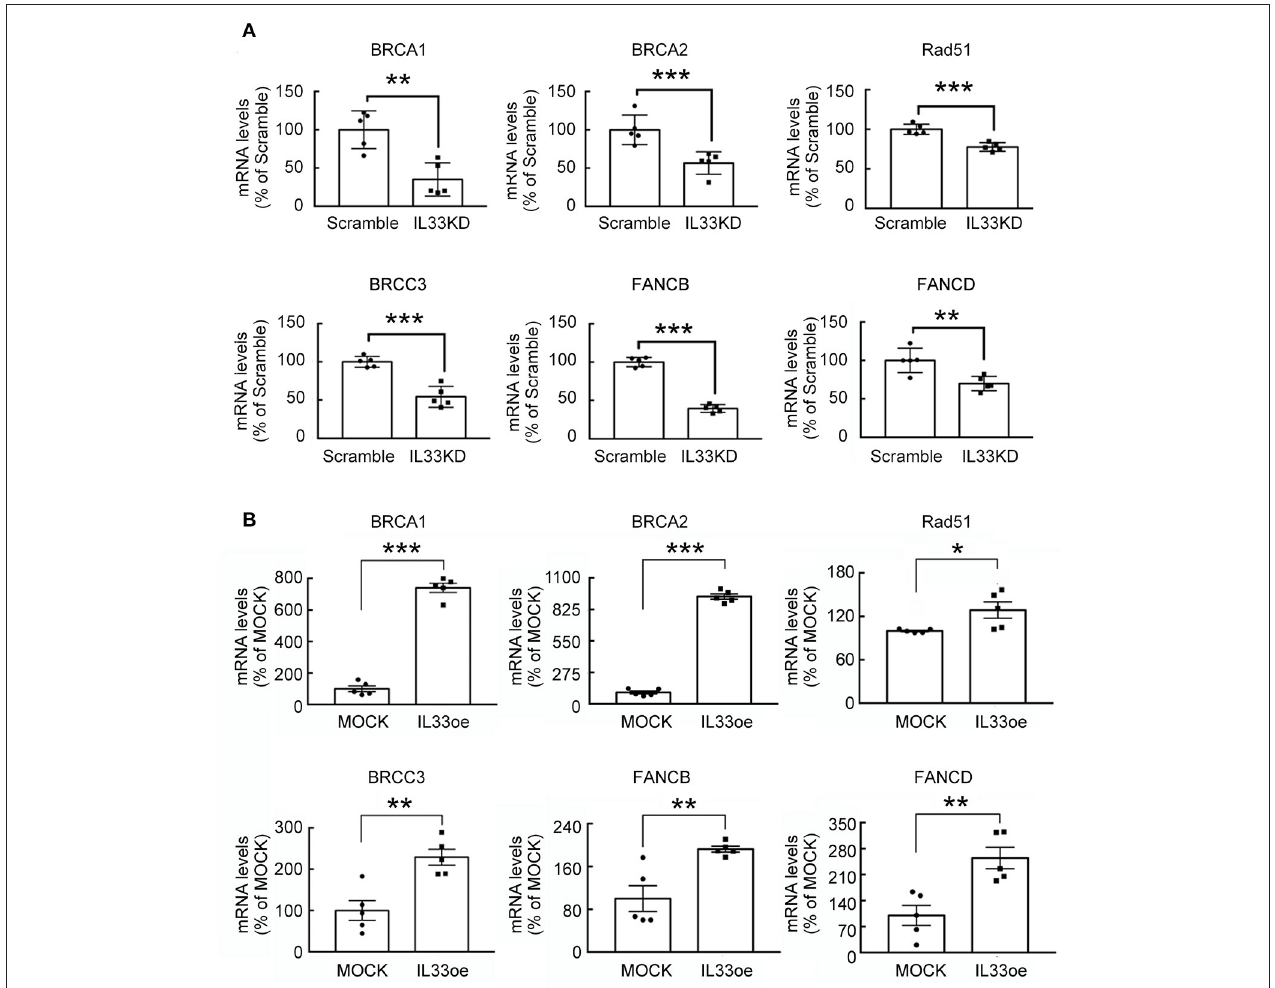
FIGURE 5 | DNA repair gene expression is mediated by IL-33 in U87MG cells. RNA samples were prepared from Scramble and IL33KD-U87MG cells (A) , as well as MOCK- and IL33oe-U87MG cells (B) . The expression of DNA repair genes (BRCA1, BRCA2, Rad51, BRCC3, FANCB, and FANCD) was measured by qPCR analysis. The results are present as mean ± SEM from the five cell passages ( n = 5). * P < 0.05, ** P < 0.01, *** P < 0.001 vs. Scramble (A) or MOCK (B) . IL-33, interleukin-33; qPCR, quantitative PCR.